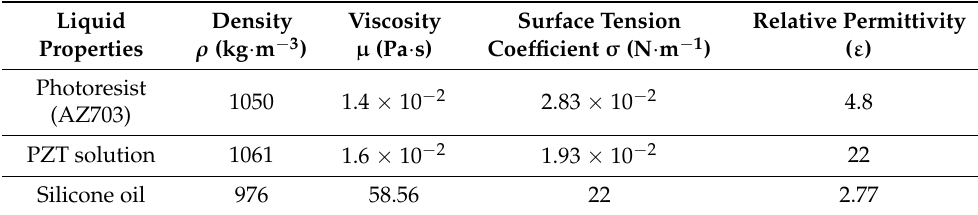
Table 1. PZT solution, photoresist AZ703, and silicone oil properties used for the DoD CE-Jet printing